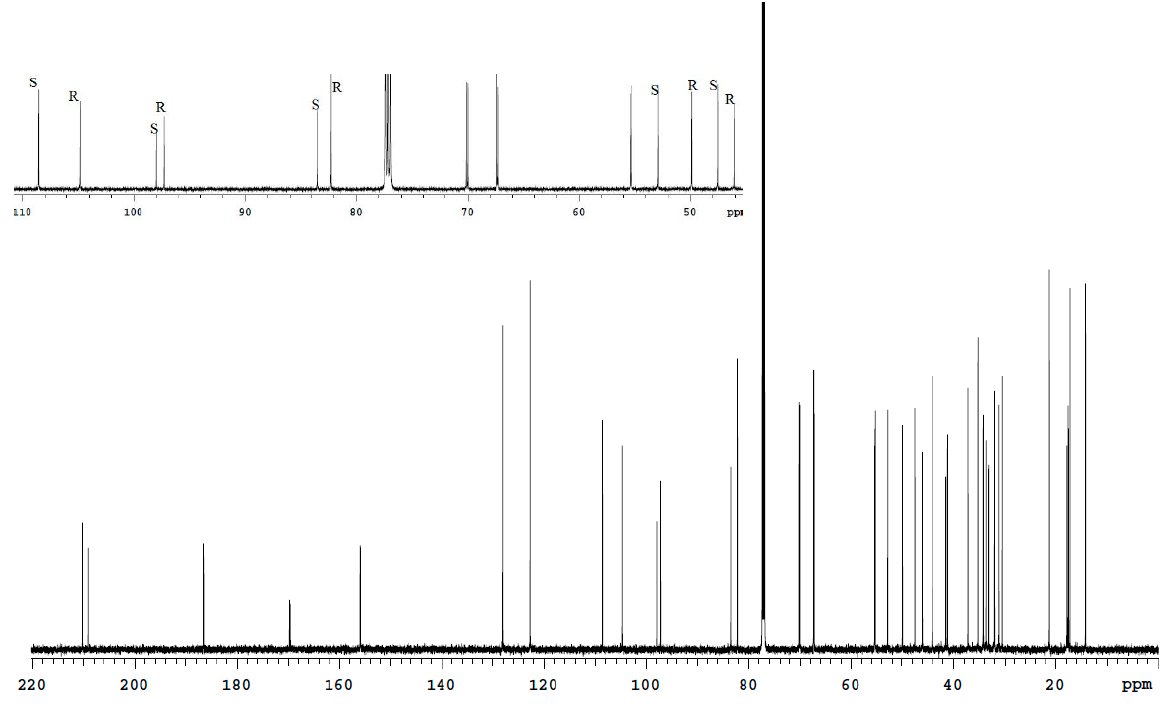
Figure 6. 13 C spectrum of the Bud-API solution in CDCl 3